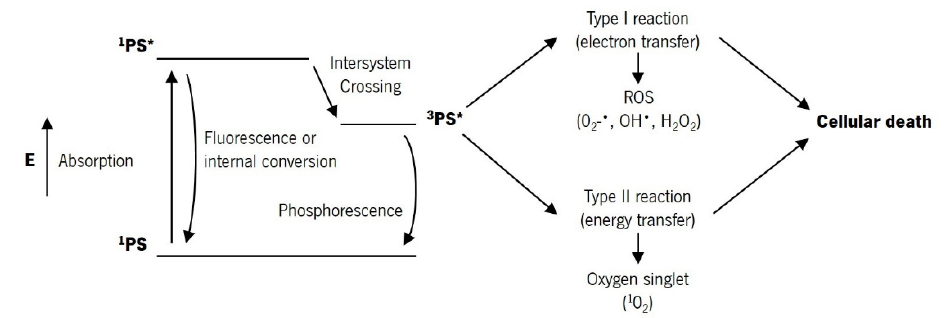
Figure 2. Modified Jablonski diagram of the PDT action mechanism (based on [13]).